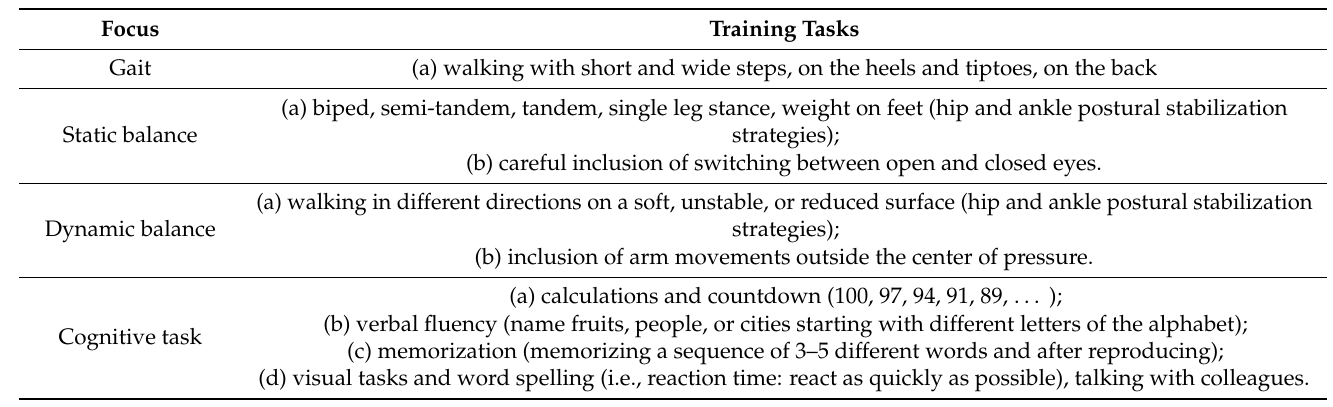
Table 1. Description of training components and task specificity. Focus Training Tasks